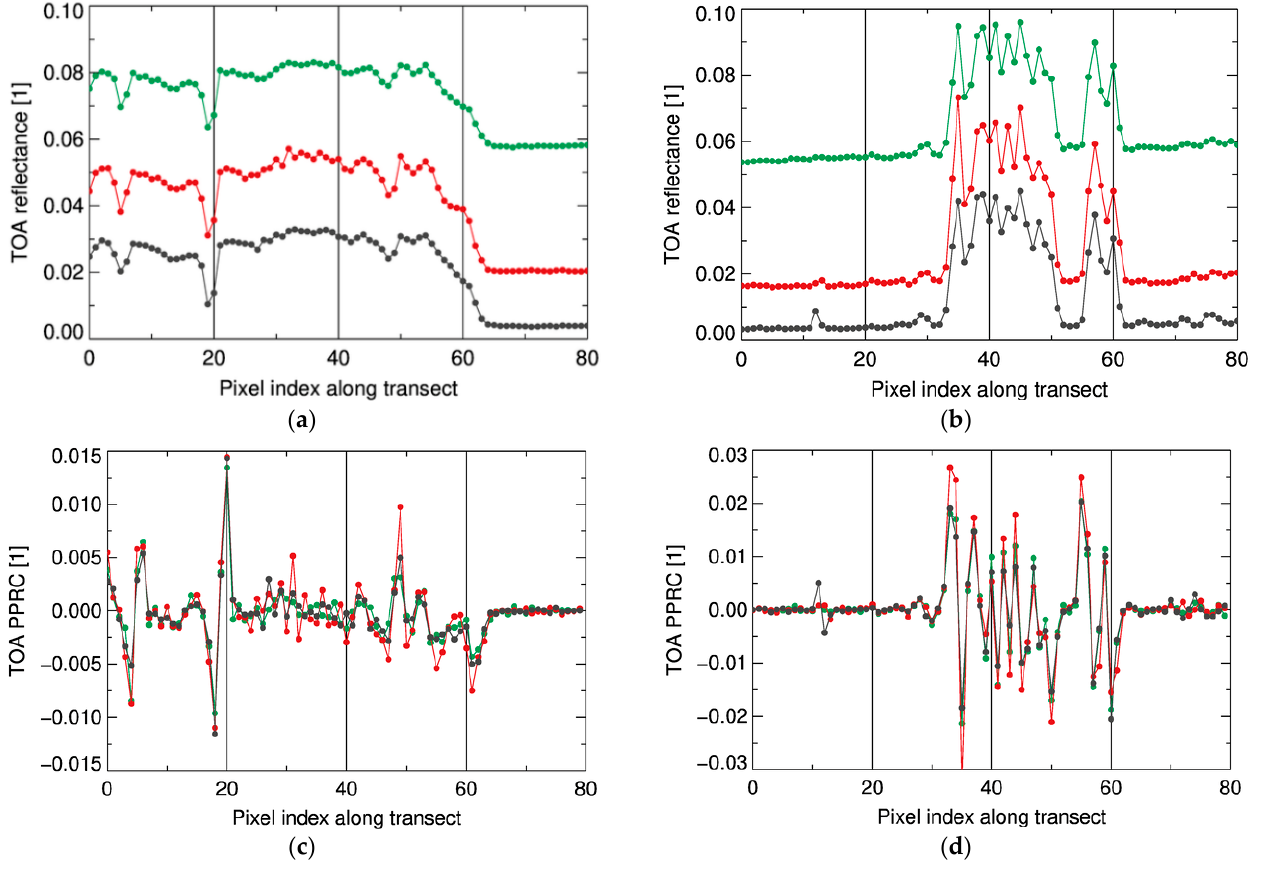
Figure 2. ( a ) Top-of-atmosphere (TOA) reflectance along Transect “1” (pixel indices 550/560 to 550/640) indicated in Figure 1; ( c ) Corresponding pixel-to-pixel reflectance contrast for OLI channels B3 (green), B5 (red), and B7 (dark grey); ( b , d ) Equivalent to ( a , c ), but for Transect “2” (pixel indices 40/120 to 120/120). Unit [1] on the y-axes represents the SI unit for dimensionless quantities.